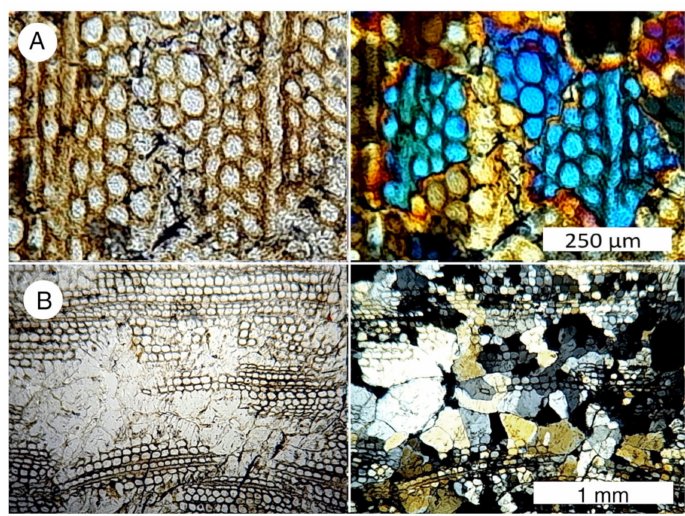
Figure 37. Transverse thin section views of Cretaceous silicified wood from Thailand. Polarized light image on right, ordinary transmitted light image on left. ( A ) Polarized light image shows that quartz occurs in crystallites that contain many cells. Bright birefringence colors are visible because the thin section is thicker than the usual 30 µ m. This color pattern is a contrast to typical silicified woods where cells were individually mineralized. Specimen from Nakhon Ratchasima Province. ( B ) In this fossil wood, mineralized cells were later disrupted by the expansive growth of quartz crystals.